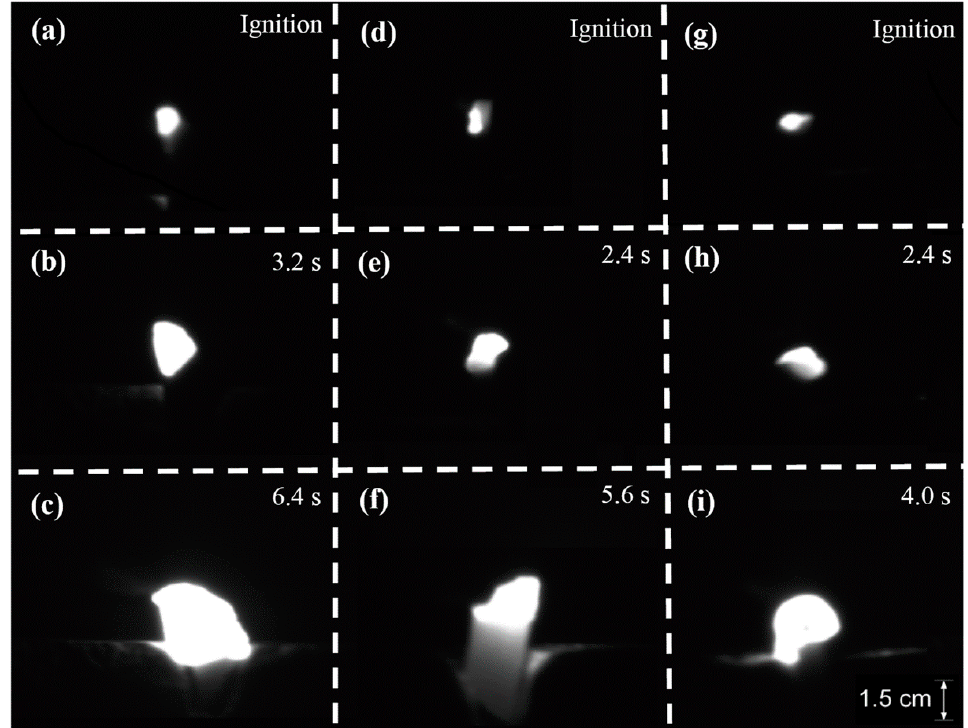
Figure 4. Captured images during burning for Ti14 alloy as obtained from: forging temperature of 1000 °C after ignition at the time of ( a ) 0.4; ( b ) 3.2; and ( c ) 6.4 s; forging temperature of 1050 °C after ignition at the time of ( d ) 0.4; ( e ) 2.4; and ( f ) 5.6 s; and forging temperature of 1100 °C after ignition at the time of ( g ) 0.4; ( h ) 2.4; and ( i ) 4.0 s. The oxygen partial pressure ( C o ) is 20% for all the three burning tests.